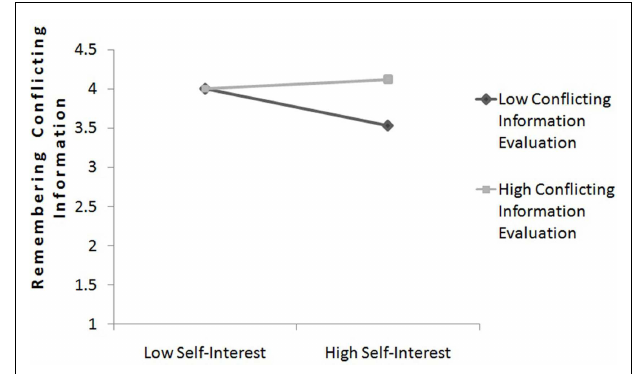
FIGURE 3 |The relationship between self-interest and remembering conflicting information as a function of the evaluation of conflicting information (study